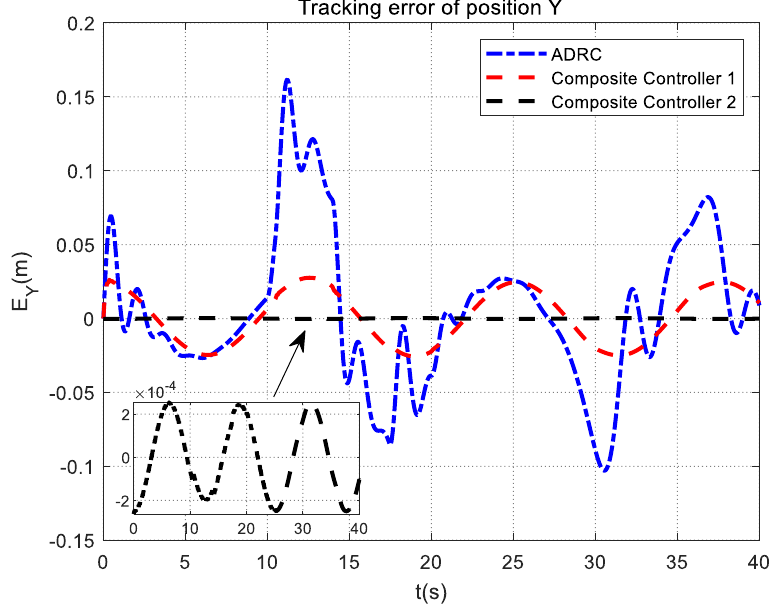
Figure 22. Tracking error of position Y control for QUAV under actuator time‑varying fault and disturbance condition.